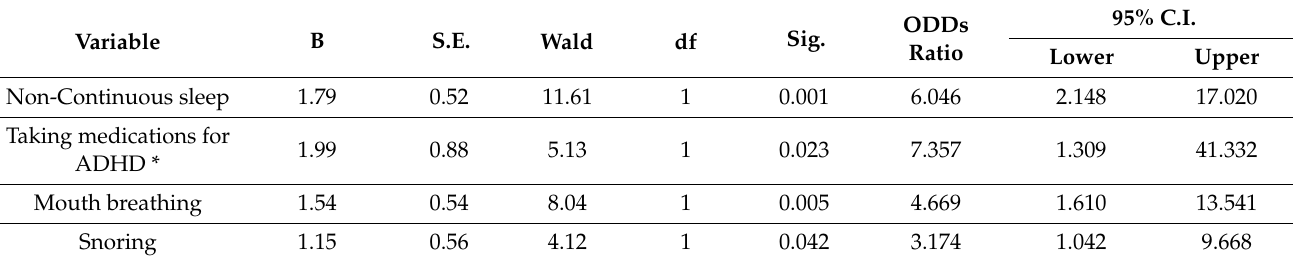
Table 5. Logistic